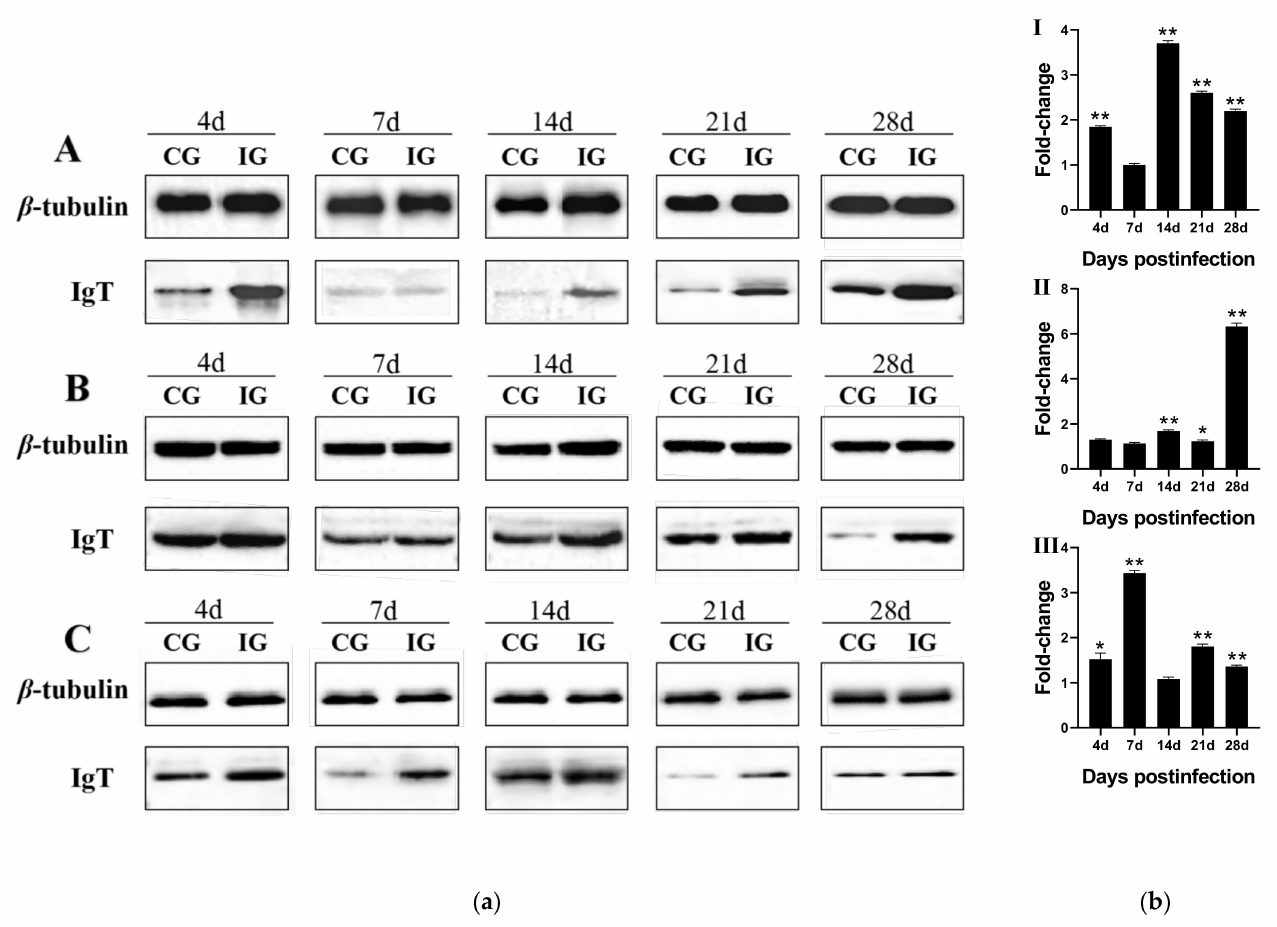
Figure 6. Western blotting analysis of Lc IgT expression in large yellow croaker infected by C. irritans . Western blotting analyzed the expression of LcIgT protein upon C. irritans infection. ( a ) Three tissues, spleen ( A ), gills ( B ), and skin ( C ), were collected from five C. irritans -infected fish or non-infected fish at 4 d, 7 d, 14 d, 21 d, and 28 d post-infection. CG: control group; IG: infection group. ( b ) The fold change values of spleen, gills, and skin, marked with (I), (II), and (III), respectively, were calculated by normalizing to the control group. Statistically significant differences are indicated with asterisks where * p < 0.05 and ** p <